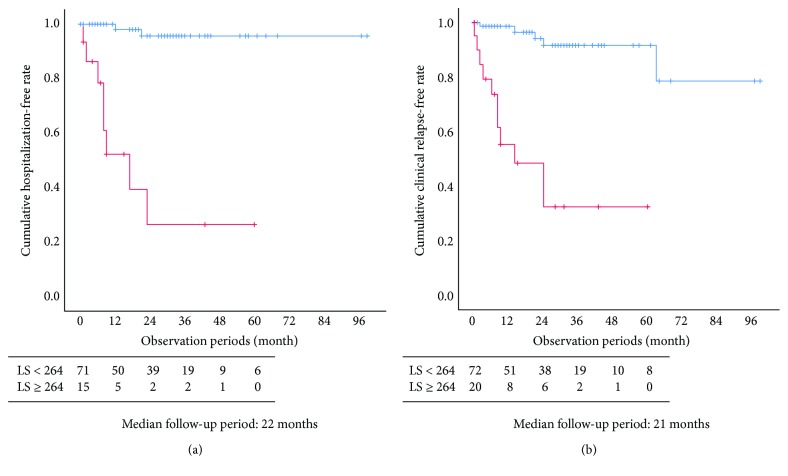
(a) Cumulative hospitalization-free rate of patients whose treatment was not changed (n = 86). Two patients with LS < 264 and eight patients with LS ≥ 264 were hospitalized during the study period. LS < 264 cases (blue line) showed significantly higher hospitalization-free rates than LS ≥ 264 cases (red line; P < 0.001). (b) Cumulative clinical relapse-free rate of patients whose treatment was not changed (n = 92). LS < 264 (blue line) showed significantly higher clinical relapse-free rates than LS ≥ 264 (red line; P < 0.001) (Kaplan-Meier method and log-rank test). Five patients with LS < 264 and 12 patients with LS ≥ 264 had clinical relapse during the study period.